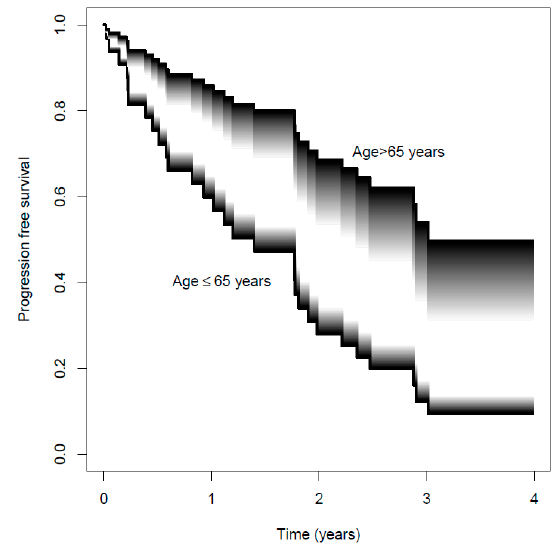
Figure 6. Survival functions predicted by the Cox model. From gray to black, AUC cum90 increases from the lower bound of the IQR (880 ng·h·mL − 1 ) to its upper bound (1412 ng·h·mL − 1 ). The bottom and top curves represent the survival functions in the younger (age ≤ 65 years, n = 25) and older (age > 65 years, n = 19) patients, respectively.